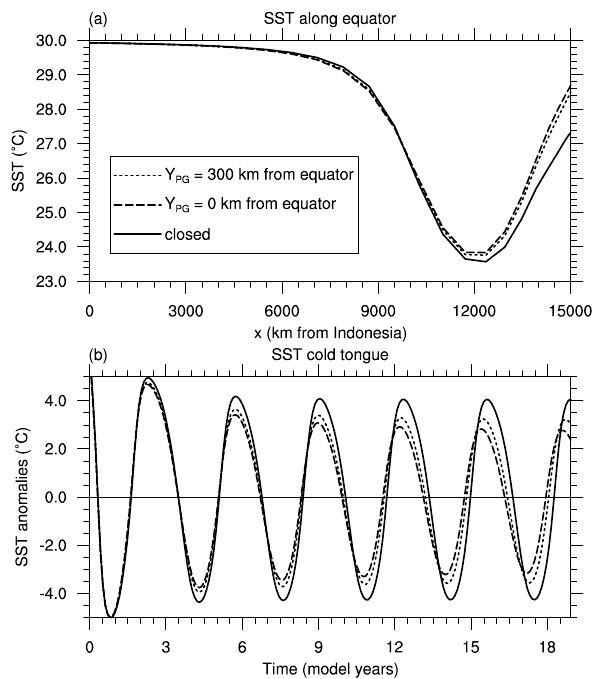
Fig. 7. Effect of the meridional position of the Panama gateway on the Pacific time-mean zonal SST distribution at the equator and the SST variability in the cold tongue. The radiation equilibrium temperature and the external wind stress are fixed at T 0 =30 ◦ C and τ 0 = 0 . 01Pa, respectively. (a) Time-mean zonal SST distribution at the equator for different positions of the Panaman gateway: 300km north of the equator, on the equator and a closed gateway. (b) SST anomalies (in ◦ C) in the cold tongue (minimum SST along the equa- tor) for different positions of the Panaman gateway: 300km north of the equator, on the equator and a closed